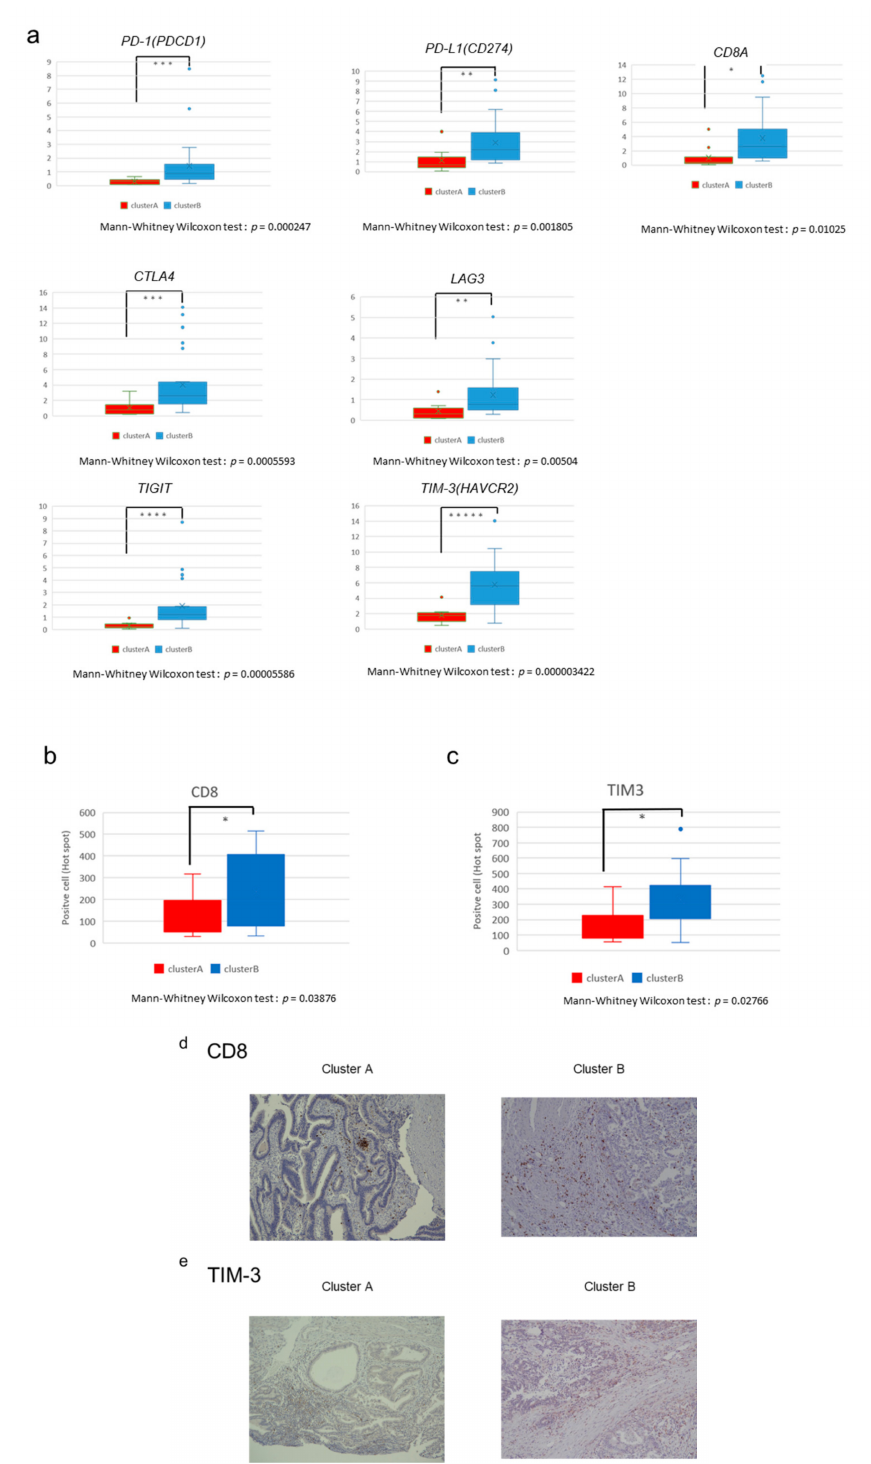
Figure 4. Expression of immune genes in GBCs. ( a ) Comparison of immune genes ( PD-1 , PD-L1 , CD8A , CTLA4 , LAG3 , TIGIT , and TIM-3 ) between the two clusters in FPKM (* Mann–Whitney Wilcoxon test, p < 0.05). The y -axis shows the FPKM of each gene. When p < 0.05, the asterisk increases with each zero digit; for example, *** for p < 0.0001. ( b ) The number of CD8-positive cells at “hot spot” areas within the same magnification ( p = 0.03876 by Mann–Whitney U test). ( c ) The number of TIM-3-positive cells at “hot spot” areas within the same magnification ( p = 0.02766 by Mann–Whitney U test). ( d ) CD8 immunostaining in the “hot spots” of the representative GBC tissues in Cluster A (left) and Cluster B (right). Positive cells are brown in color. Each sample were observed with a 10 × objective lens. ( e ) TIM-3 immunostaining in the “hot spots” of representative GBC tissues in Cluster A (left) and Cluster B (right). Each sample was observed with a 10 × objective